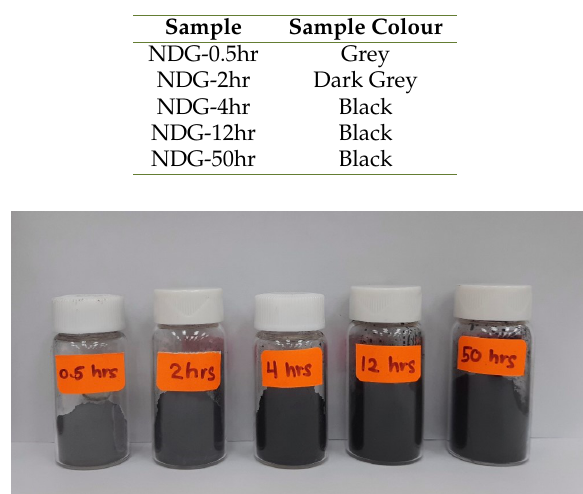
Table 1. Sample colour after ball milling.